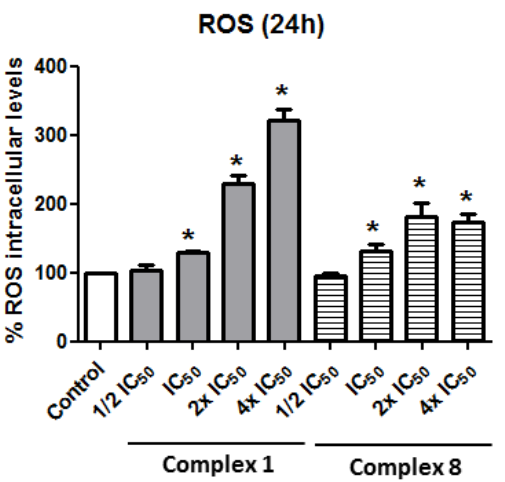
Figure 7. Measurement of the intracellular levels of ROS after the treatment of Caco-2 cells with complexes 1 and 8 at different concentrations for 24 h. * p < 0.05 compared to the control.